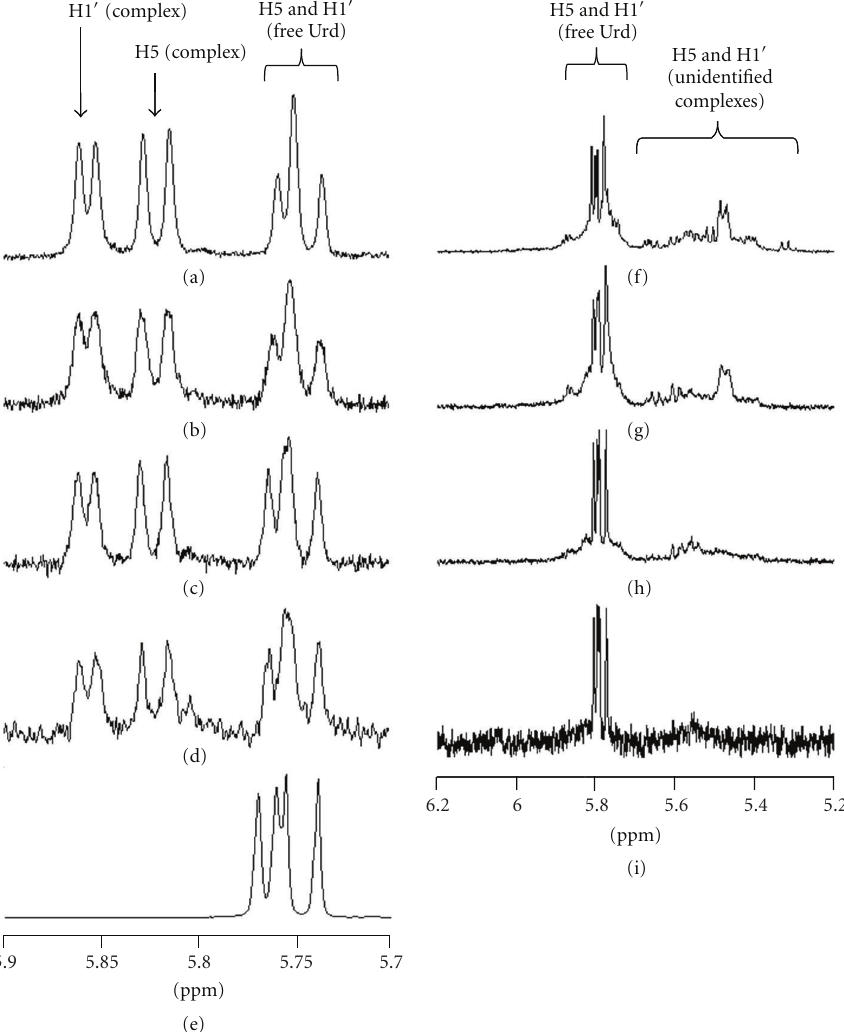
Figure 1: 1 H NMR spectra of uridine (H5 and H1 (cid:2) ) at various concentrations of uridine, 1 and Pd 2+ at pH 7.3. (a) [Urd] = [ 1 ] = 3.6mmolL − 1 , [Pd 2+ ] = 2.52 mmolL − 1 ; (b) [Urd] = [ 1 ] = 1.49 mmolL − 1 , [Pd 2+ ] = 1.04mmol L − 1 ; ( c) [Urd] = [ 1 ] = 0.57 mmolL − 1 , [Pd 2+ ] = 0.40mmolL − 1 ; (d): [Urd] = [ 1 ] = 0.061 mmolL − 1 , [Pd 2+ ] = 0.042 mmolL − 1 ; (e) [Urd] = [ 1 ] = 13.84 mmolL − 1 , [Pd 2+ ] = 0; (f) [Urd] = 3.6mmolL − 1 , [Pd 2+ ] = 2.52 mmolL − 1 ; (g) [Urd] = 1.49 mmolL − 1 , [Pd 2+ ] = 1.04mmolL − 1 ; ( h) [Urd] = 0.57mmolL − 1 , [Pd 2+ ]